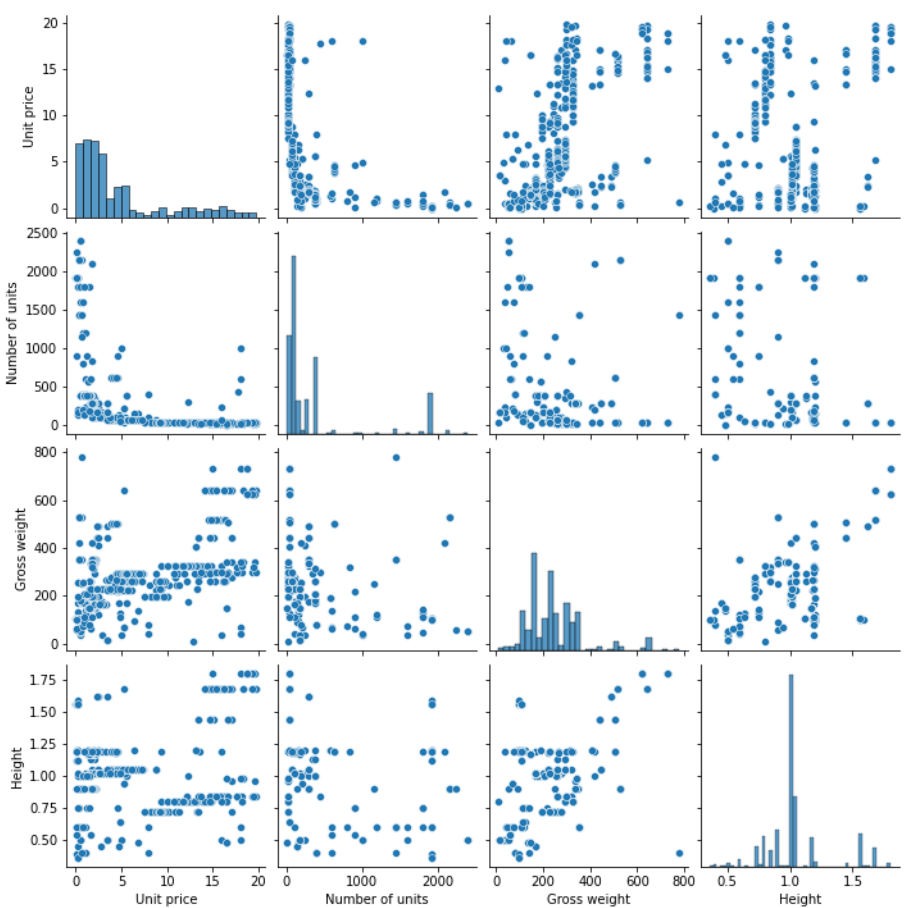
Figure A2. Pairwise relationships in a dataset. Diagonal plots correspond to a univariate distribution plot demonstrating the marginal distribution of each